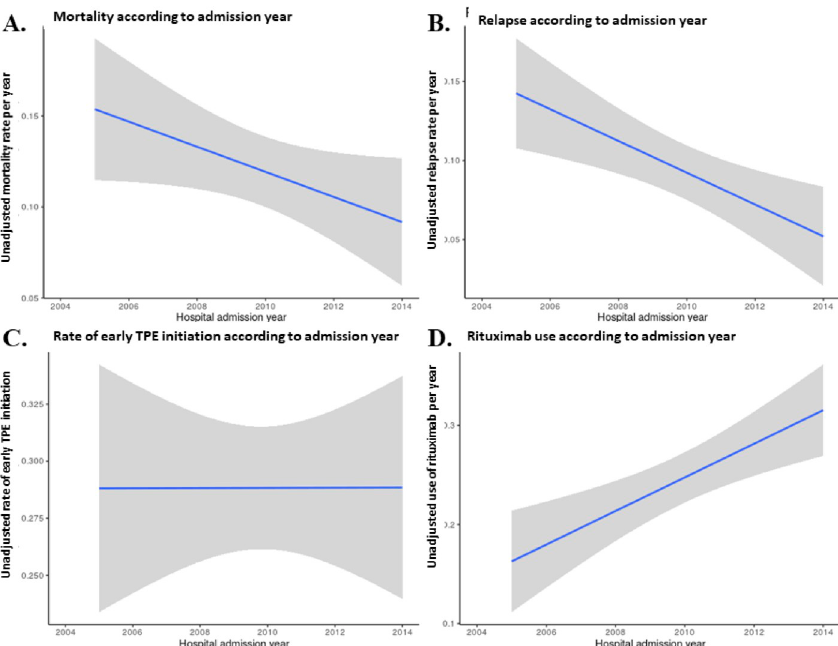
Fig 3. Trends of mortality, relapse, early TPE initiation and rituximab use over time. Unadjusted rates of mortality ( A ), relapse ( B ), early TPE initiation, ( C ) and rituximab use ( D ) in patients with TTP according to the year of admission. Gray areas reflect 95% confidence interval of changes.